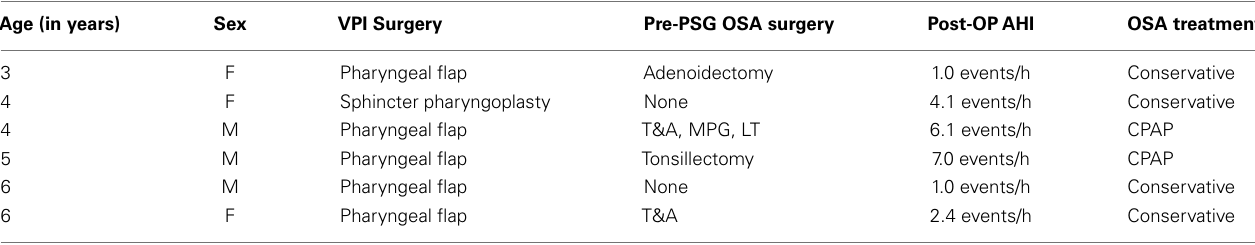
Table 2 | Demographics of the patients who underwent polysomnography, including the surgery performed for theirVPI, pre and post-polysomnography treatments of OSA, andAHI results of the PSG . Age (in years) VPI Surgery Pre-PSG OSA surgery Post-OPAHI OSA treatment Adenoidectomy 1.0 events/h